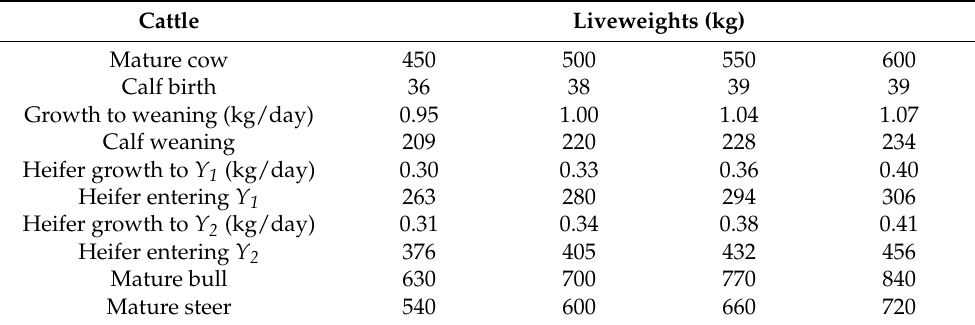
Table 2. Liveweights for cattle for scenario B with varying mature cow liveweight. Calf birth and weaning weights were decreasing ratios of mature cow liveweights as cow liveweight increased. Heifers were 12 months of age when entering Y 1 and 24 months of age when entering Y 2 .